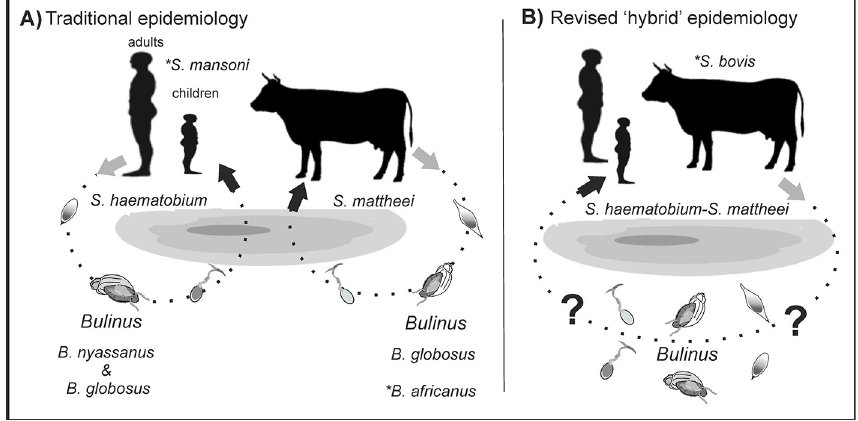
Fig 1. Reconciling schistosome hybridization with epidemiological models of schistosomiasis transmission. (A) The current model of urogenital schistosomiasis in Malawi involves discrete transmission cycles and does not formally take into account the importance of multi-species coinfections. (B) A revised model of urogenital schistosomiasis with overlapping transmission potentials with schistosome worms also being influenced or interacting with other species present (e.g., S . mansoni within coinfected people or S . bovis in cattle). Note � S . mansoni –intestinal schistosomiasis is now emerging along the Lake Malawi shoreline and is transmitted by Biomphalaria (which is not depicted here for brevity), � B. africanus has now been detected in the lake (MH Al-Harbi personal observation ) and is a known intermediate host of several other S . haematobium group species, which might drive novel environmental transmission